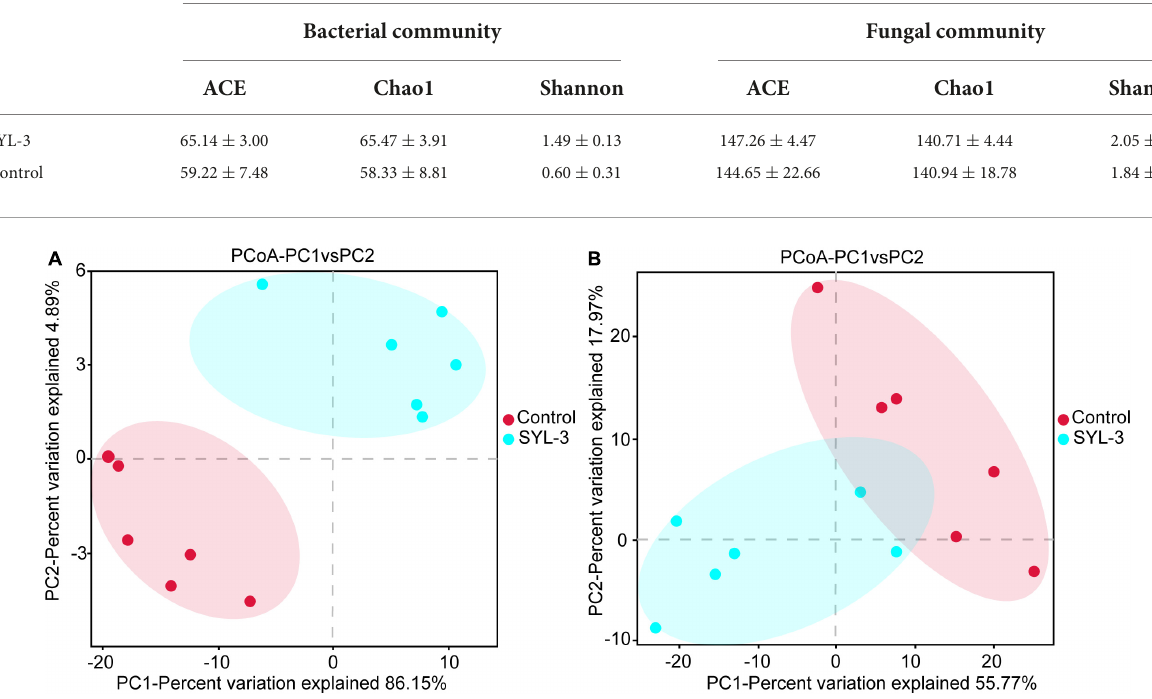
TABLE 3 Statistics of alpha diversity index of phyllosphere microbial community.